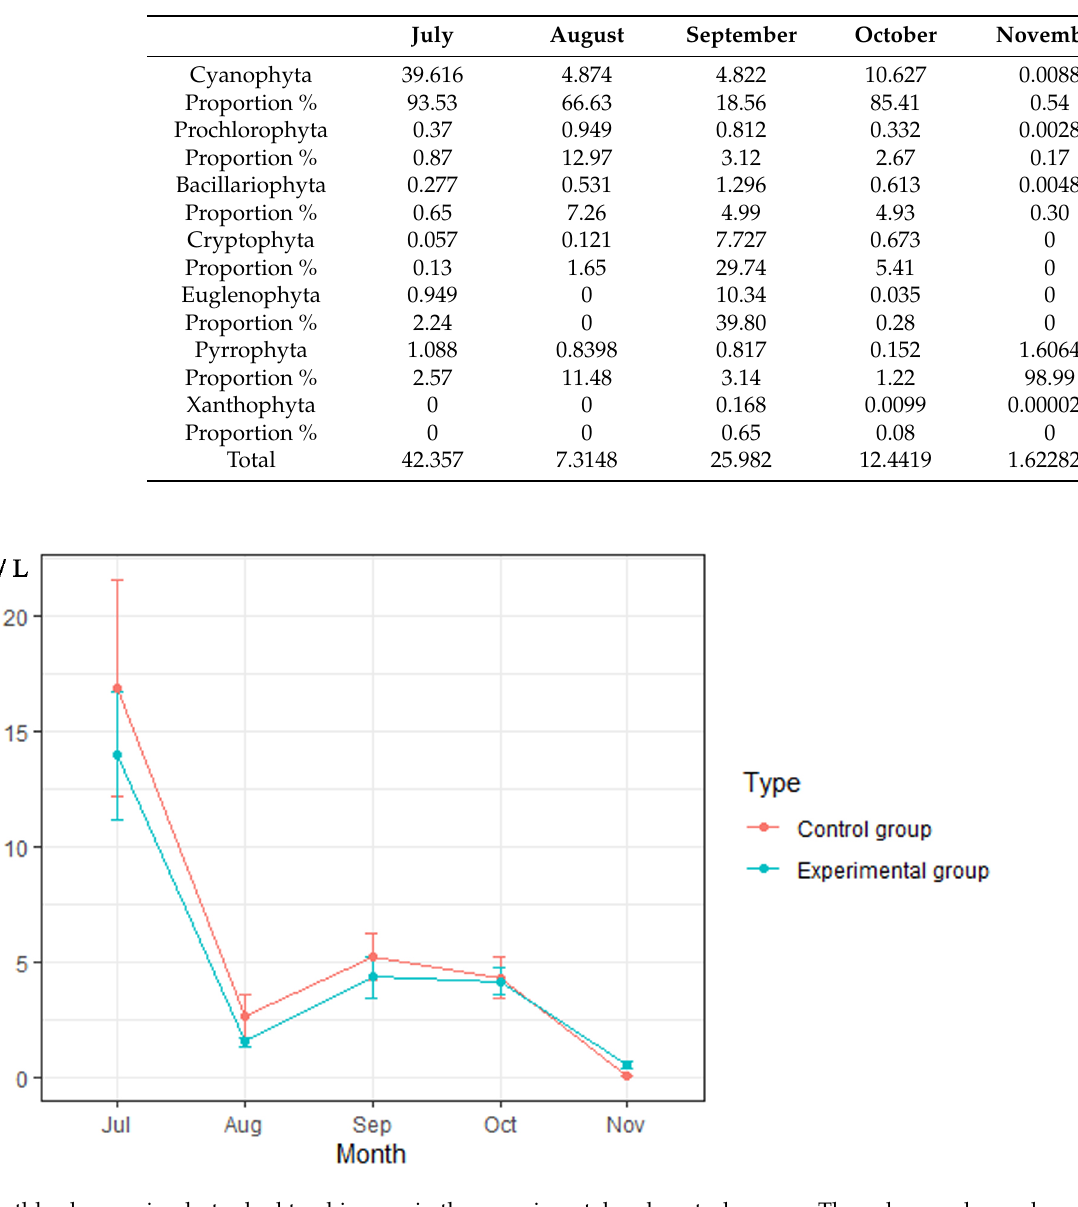
Figure 5. Monthly changes in phytoplankton biomass in the experimental and control groups. The values and error bars represent means ± SE ( n =